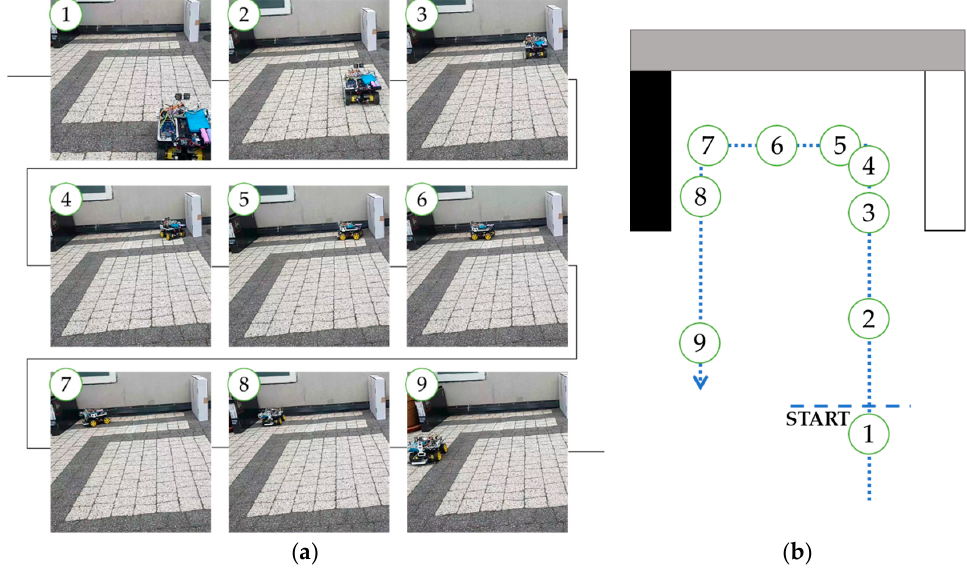
Figure 17. Subsequent frames presenting functional test of the platform: ( a ) real model view; ( b ) graph of the trajectory.